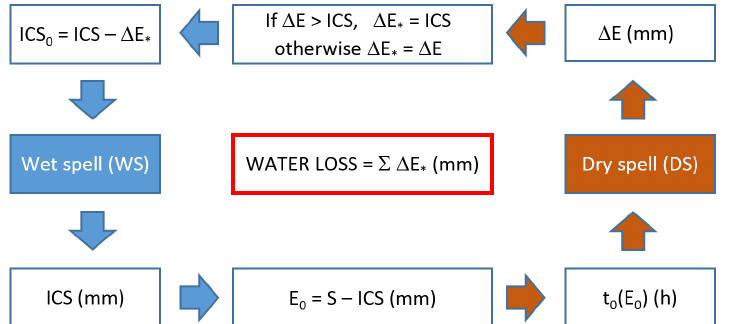
Figure 9. Schematic flowchart of the proposed methodology to calculate ICS during WS , and ∆ E (or ∆ E ∗ ) during DS